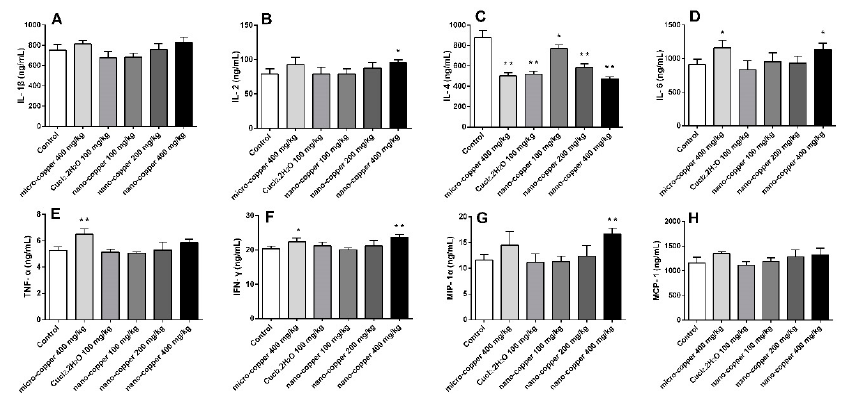
Figure 3. The levels of cytokines in copper treated rats. IL-1 β ( A ), IL-2 ( B ), IL-4 ( C ), IL-6 ( D ), IFN- γ ( E ), TNF- α ( F ), MIP-1 ( G ), MCP-1 ( H ). * p < 0.05, ** p < 0.01 vs. control group. High dose of nano-copper